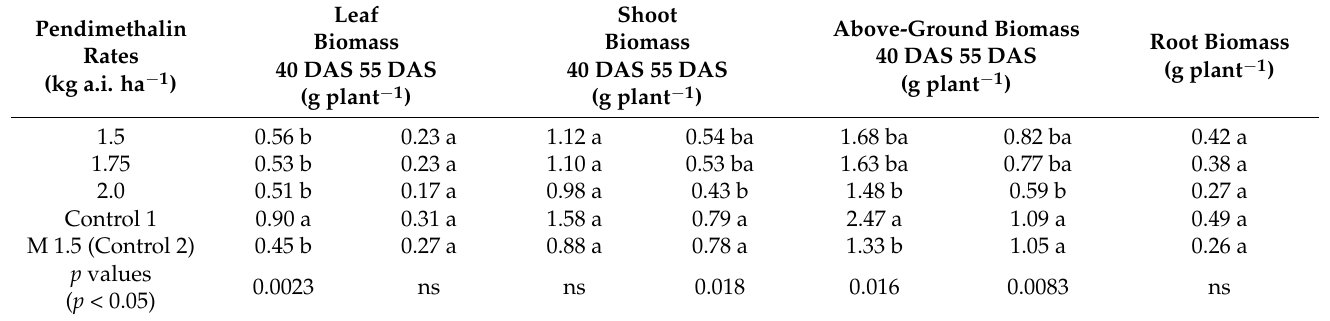
Table 1. Effects of pre-emergence herbicide on leaf, shoot, above-ground and root biomass of barnyard